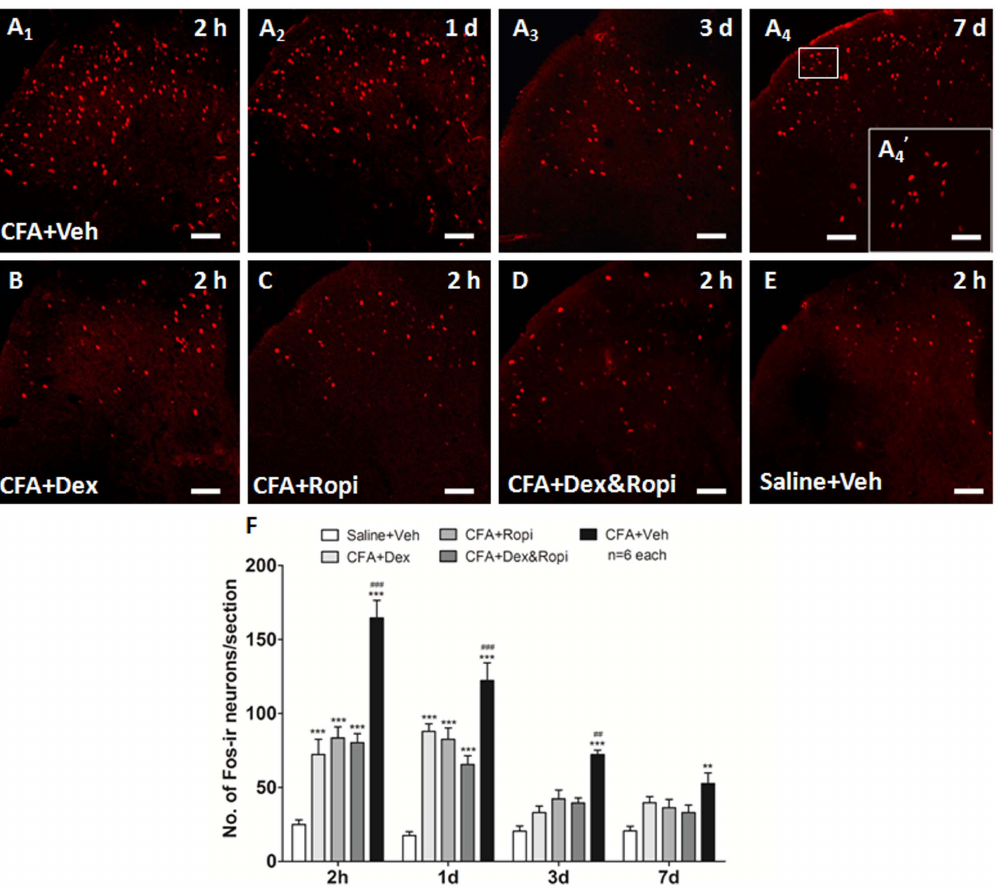
Figure 5. Effect of i.t. Dex, Ropi, or their combination on CFA-induced neuronal activation. s.c. CFA-induced thermal hyperalgesia was accompanied with the increase in the number of Fos-ir neurons to the peak at 2 h after injection, and gradually reduced but sustained to day 7 in the ipsilateral SDH ( A 1 , A 4 ). Both i.t. individual and concomitant medications significantly inhibited neuronal activation indicated by less number of Fos- ir neurons in the ipsilateral SDH at 2 h after s.c. CFA injection ( B , E ). Number of Fos-ir neurons was presented in F at 2 h, 1, 3 and 7 d after s.c. CFA injection, respectively. * p , 0.05, ** p , 0.01, *** p , 0.001, compared with Saline-Veh group; ## p , 0.01, ### p , 0.001, compared with CFA- Dex&Ropi group. Scalebars=10 m m in A 4’ , 50 m m in A 1 , A 4 and B , E